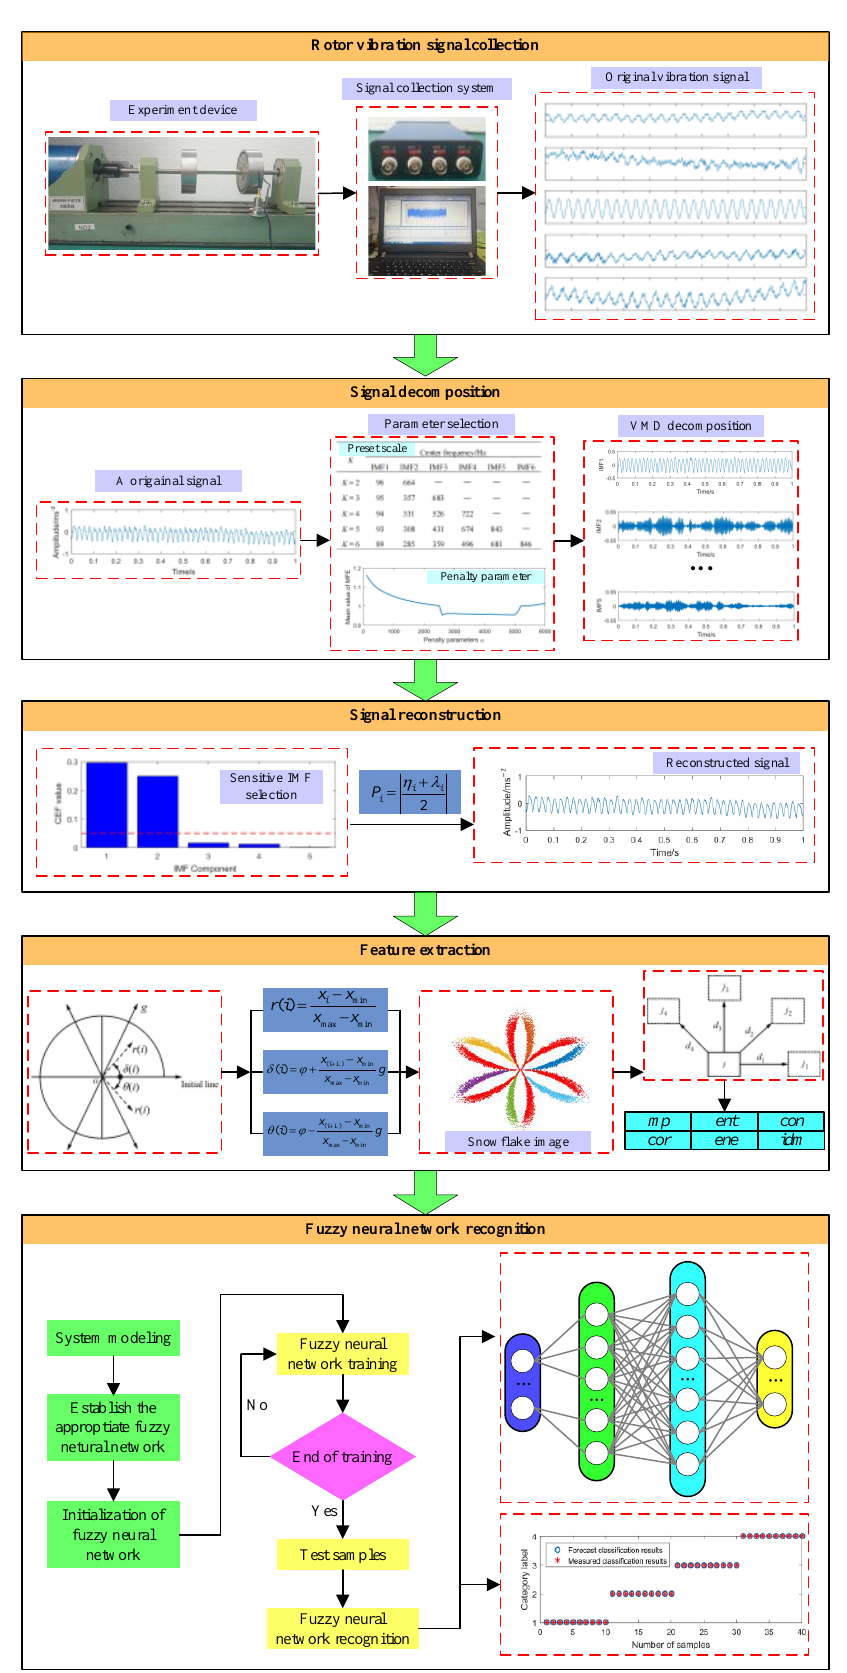
Figure 1. Flow chart of rotor fault diagnosis based on VMD symmetric polar image and fuzzy neural network.